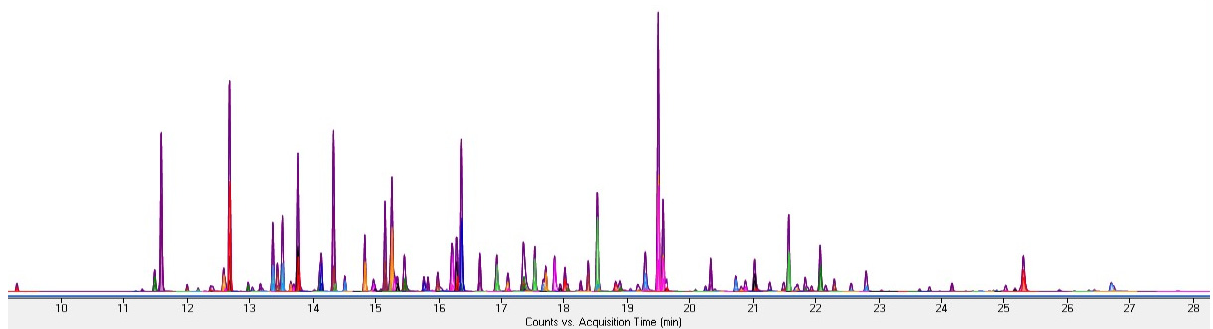
Figure 1. GC-MS/MS standard solution chromatogram. GC: gas chromatography; MS: mass spec- Figure 1. GC-MS/MSstandardsolutionchromatogram. GC:gaschromatography; MS:massspectrometry. trometry. LC-MS/MS Target